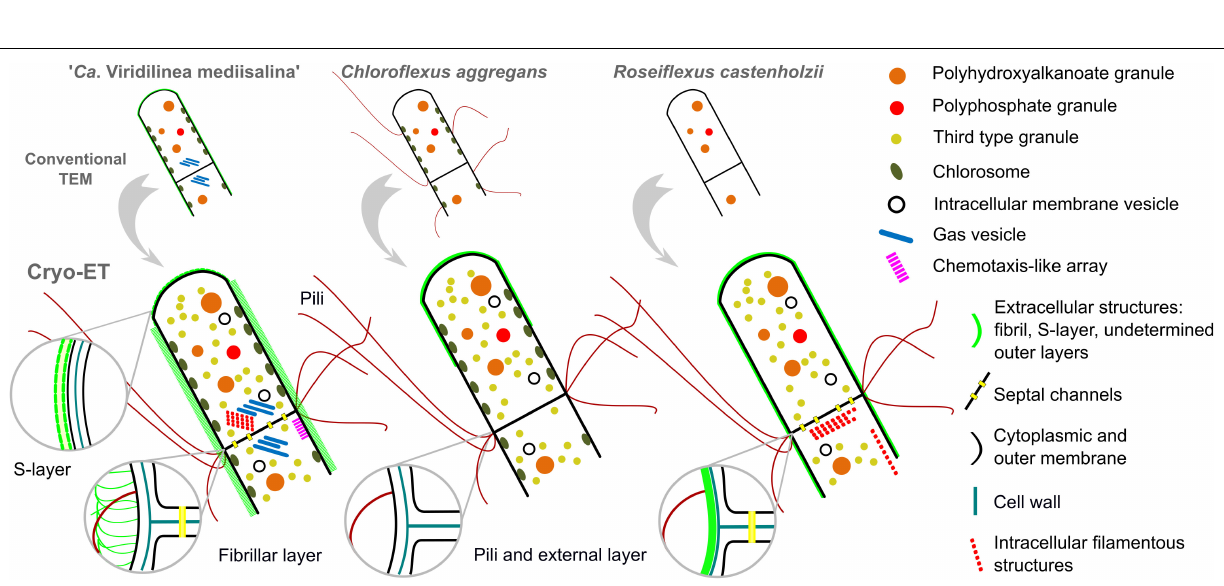
Frontiers in Microbiology |